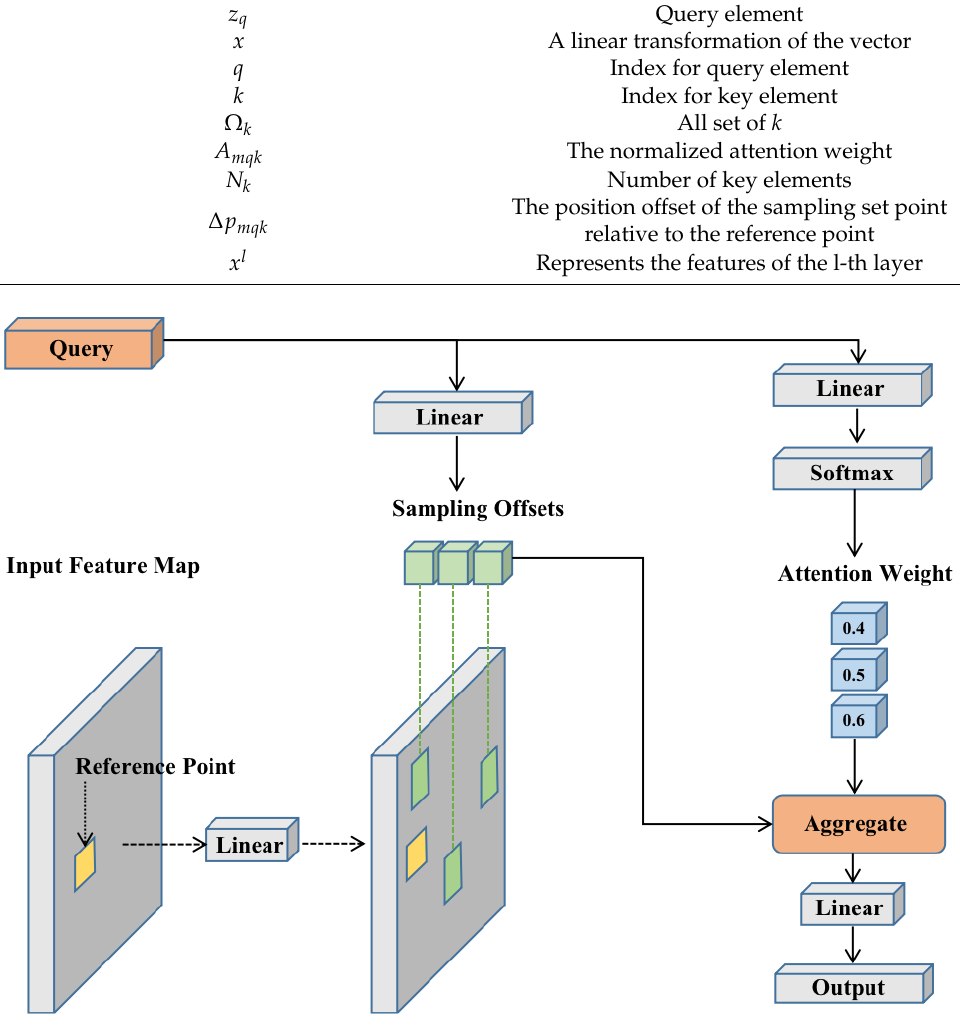
Figure 7. The structure of the deformable attention